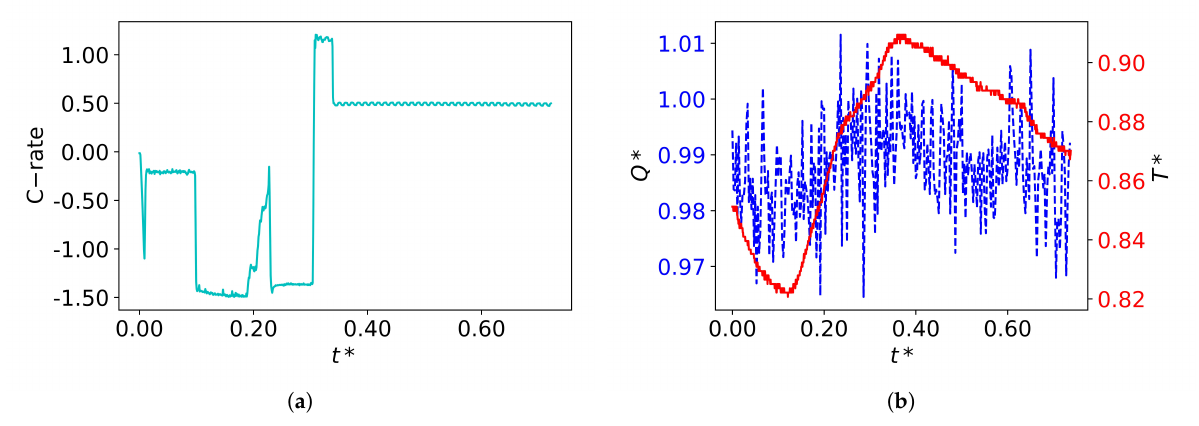
Figure 2. Case 1 test scenario: ( a ) Current profile and ( b ) inlet volumetric flow rate ( Q ∗ ) and temperature of the coolant ( T ∗ )